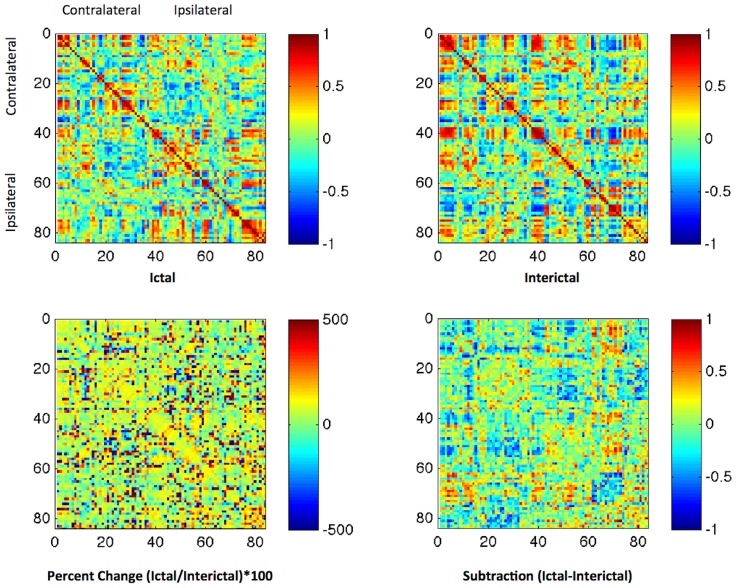
State dependent connectivity matrices.The upper panel displays the connectivity matrices illustrating the strength of connectivity across 84 regions of interest. The numbering of regions is equivalent to Table S1. Regions 1 to 42 represent the hemisphere contralateral to seizure onset, while 43 to 84 represent the homologous regions (1–43, 2–44, and so on) on the ipsilateral side. Each matrix entry represents the correlation coefficient “R” between each pair of regions. The lower panel demonstrates the percent change (ictal/interictal) and the difference between states.